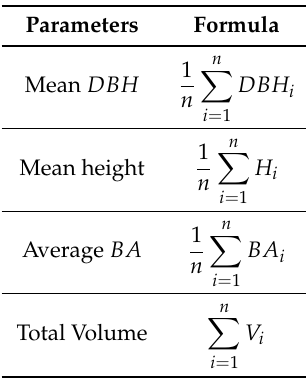
Table 1. Estimation of parameters for a complex forest patch with n number of trees based on individual tree parameters.